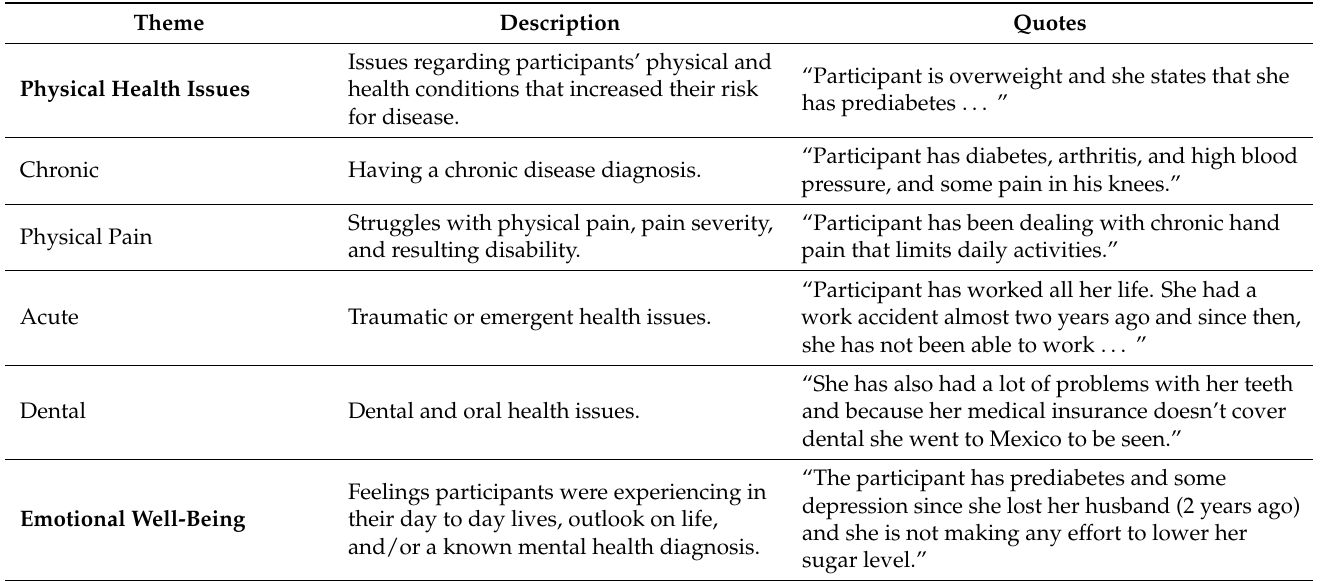
Table 3. Emerging themes and sample quotes from the content analysis a